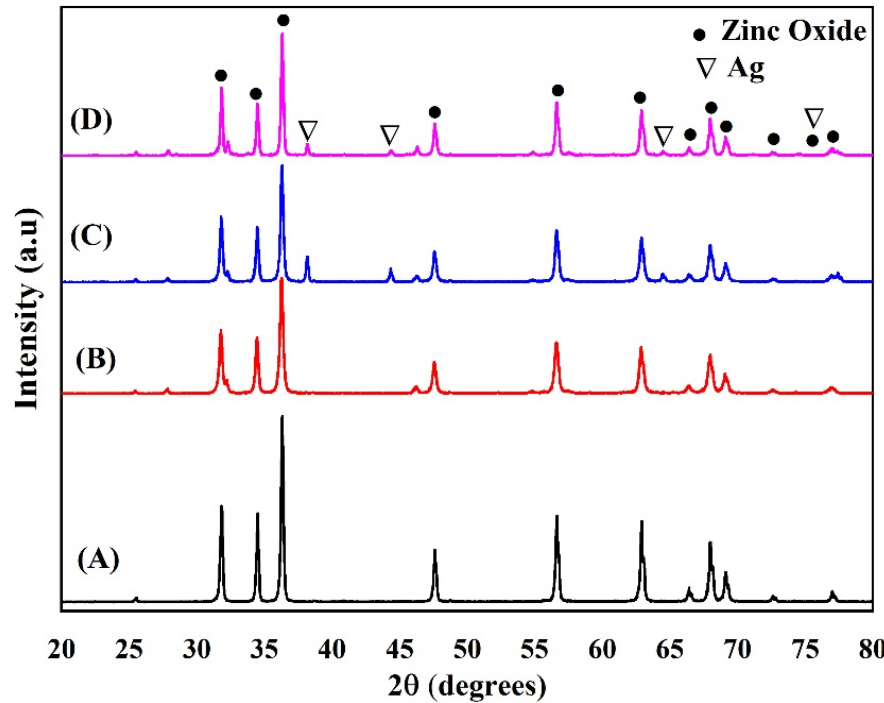
Figure 2. XRD patterns of Zn 1 − x Ag x O. ( A ) x = 0.0, ( B ) x = 0.03, ( C ) x = 0.06, and ( D ) x = 0.09.